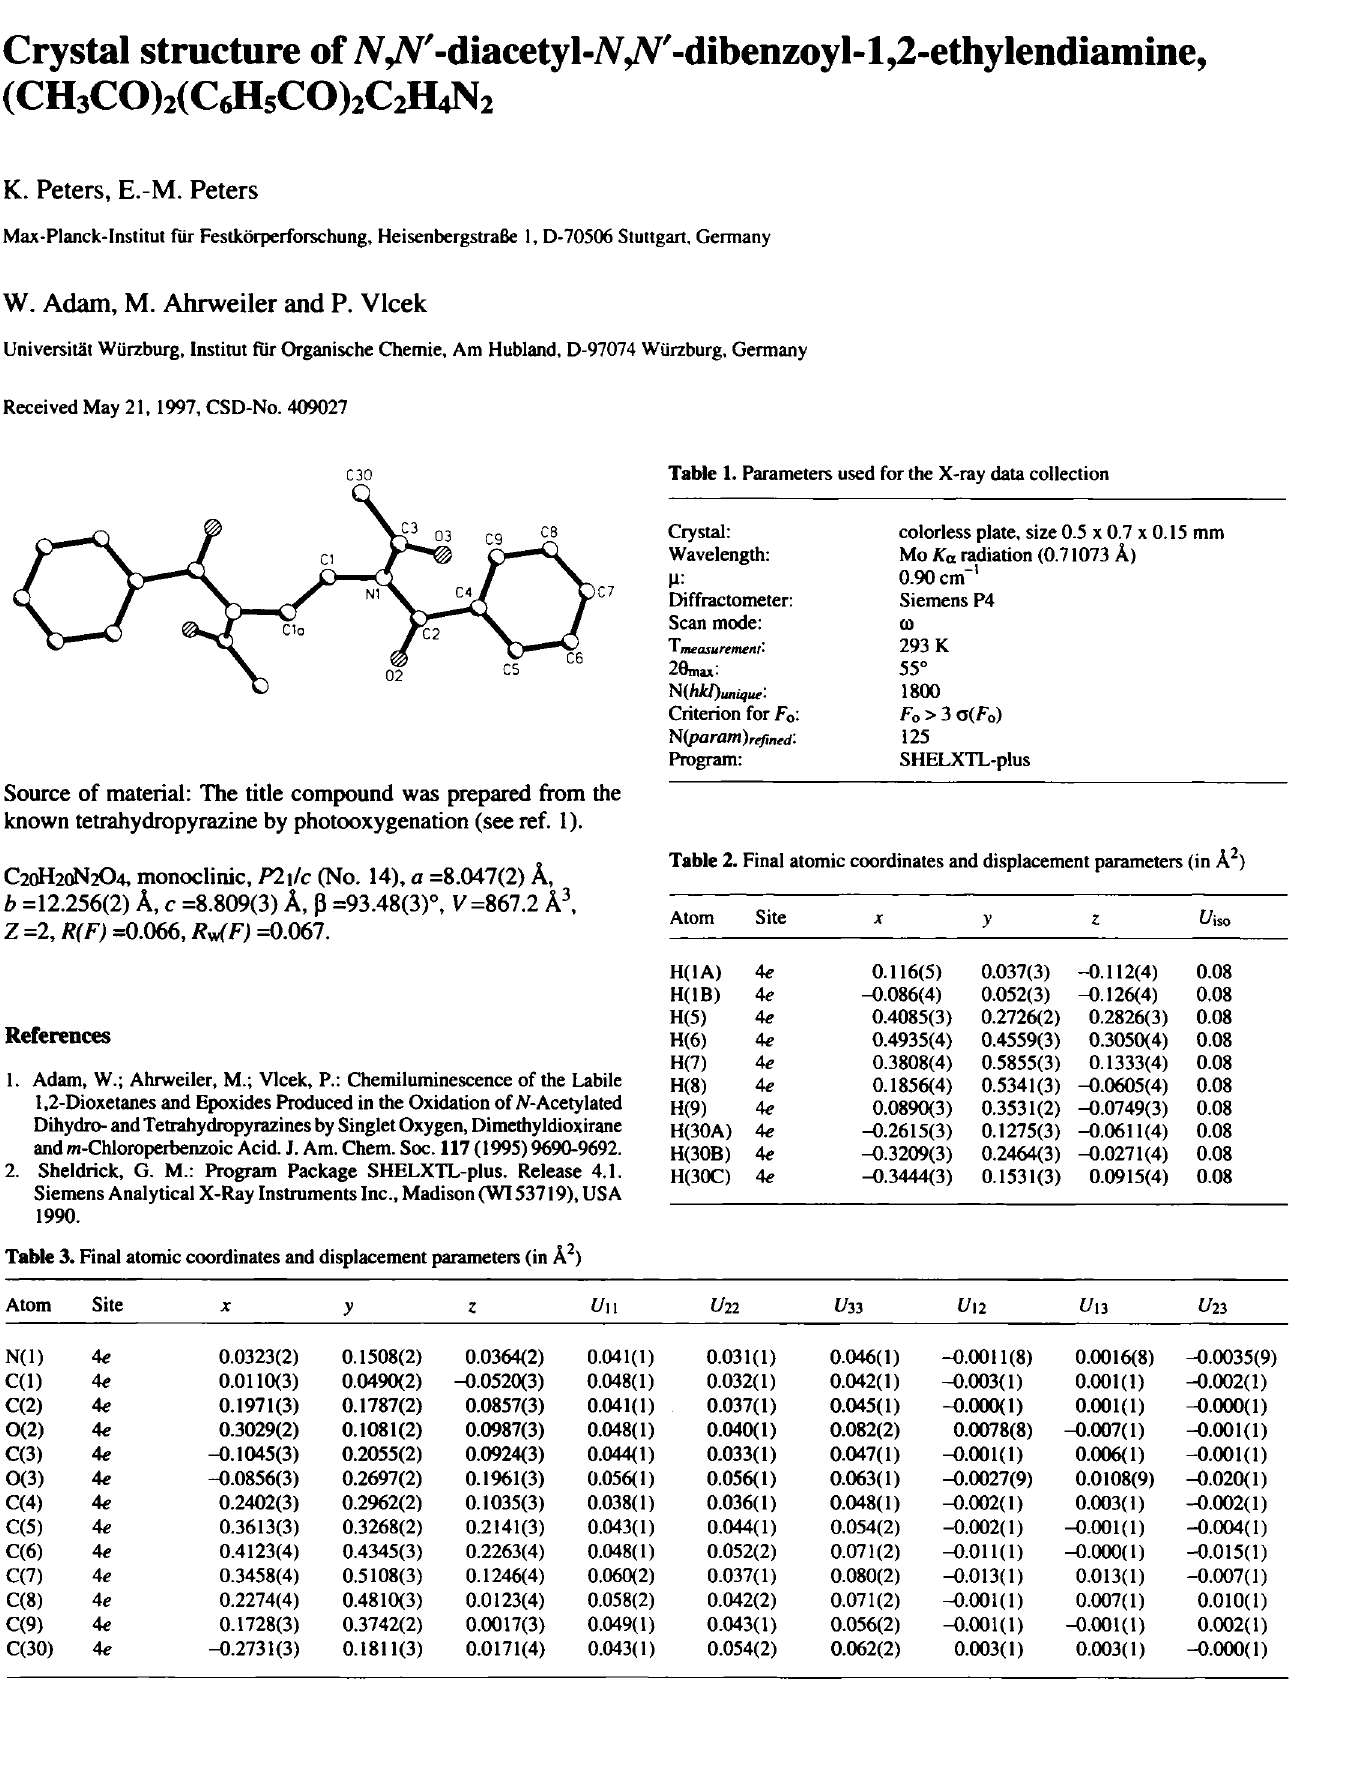
Table 1. Parameters used for the X-ray data collection